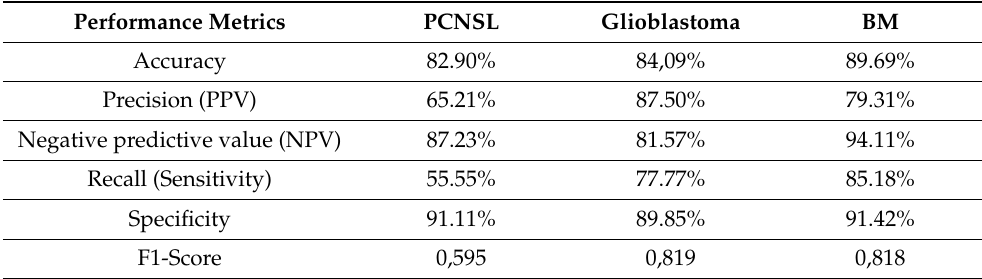
Table 3. Neuroradiologist (Gold standard) performance metrics in differentiating PCNSL, glioblastoma and BM in the cohort examined.